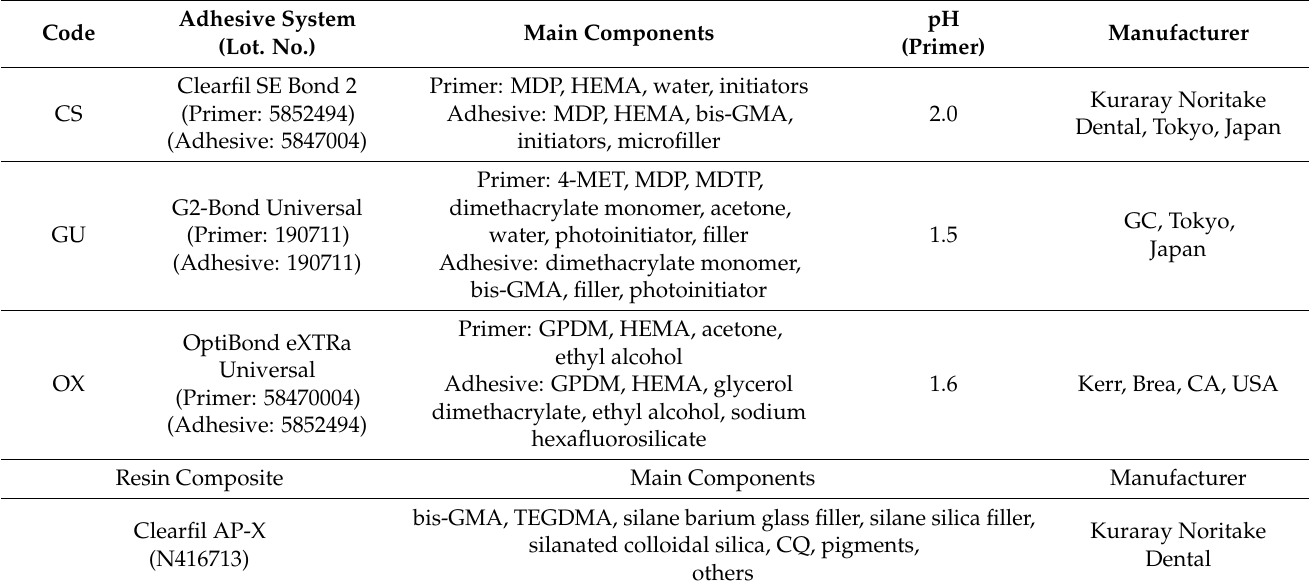
Table 1. Materials used in this